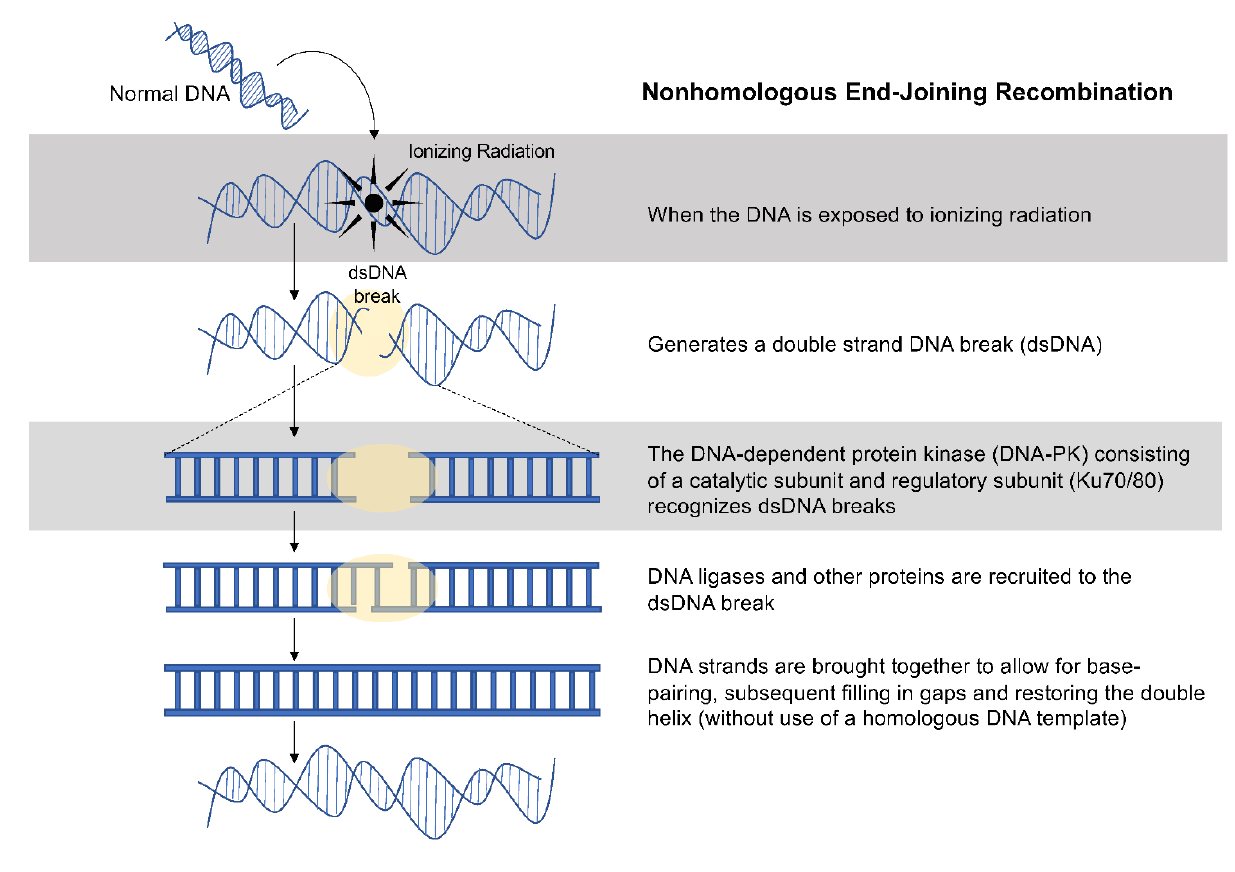
Figure 2. Schematic representation of nonhomologous recombination after ionizing radiation. Nonhomologous recombina- tion is a method of DNA repair that can occur following ionizing radiation. In this process, DNA-dependent protein kinase (DNA-PK) recognizes double-stranded DNA (dsDNA) breaks and recruits other proteins to repair the DNA injury without the use of a homologous DNA template.